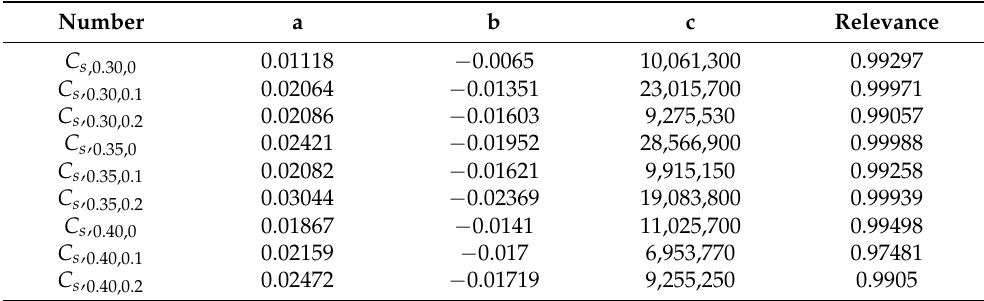
Table 7. Results and goodness of curve fitting ( C S ).